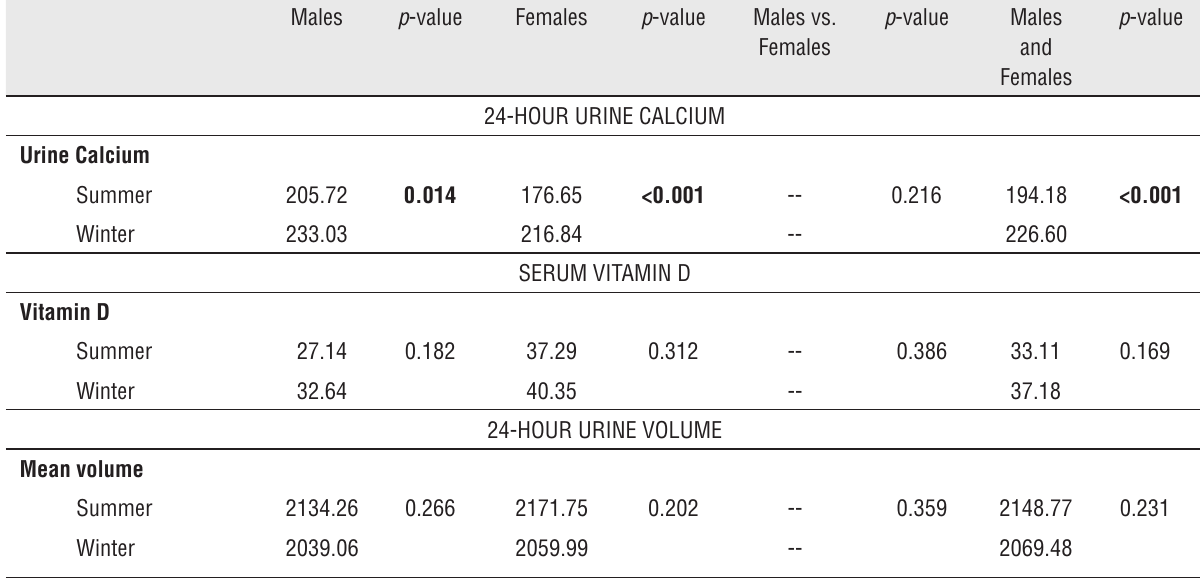
Table 2 - Seasonal variations